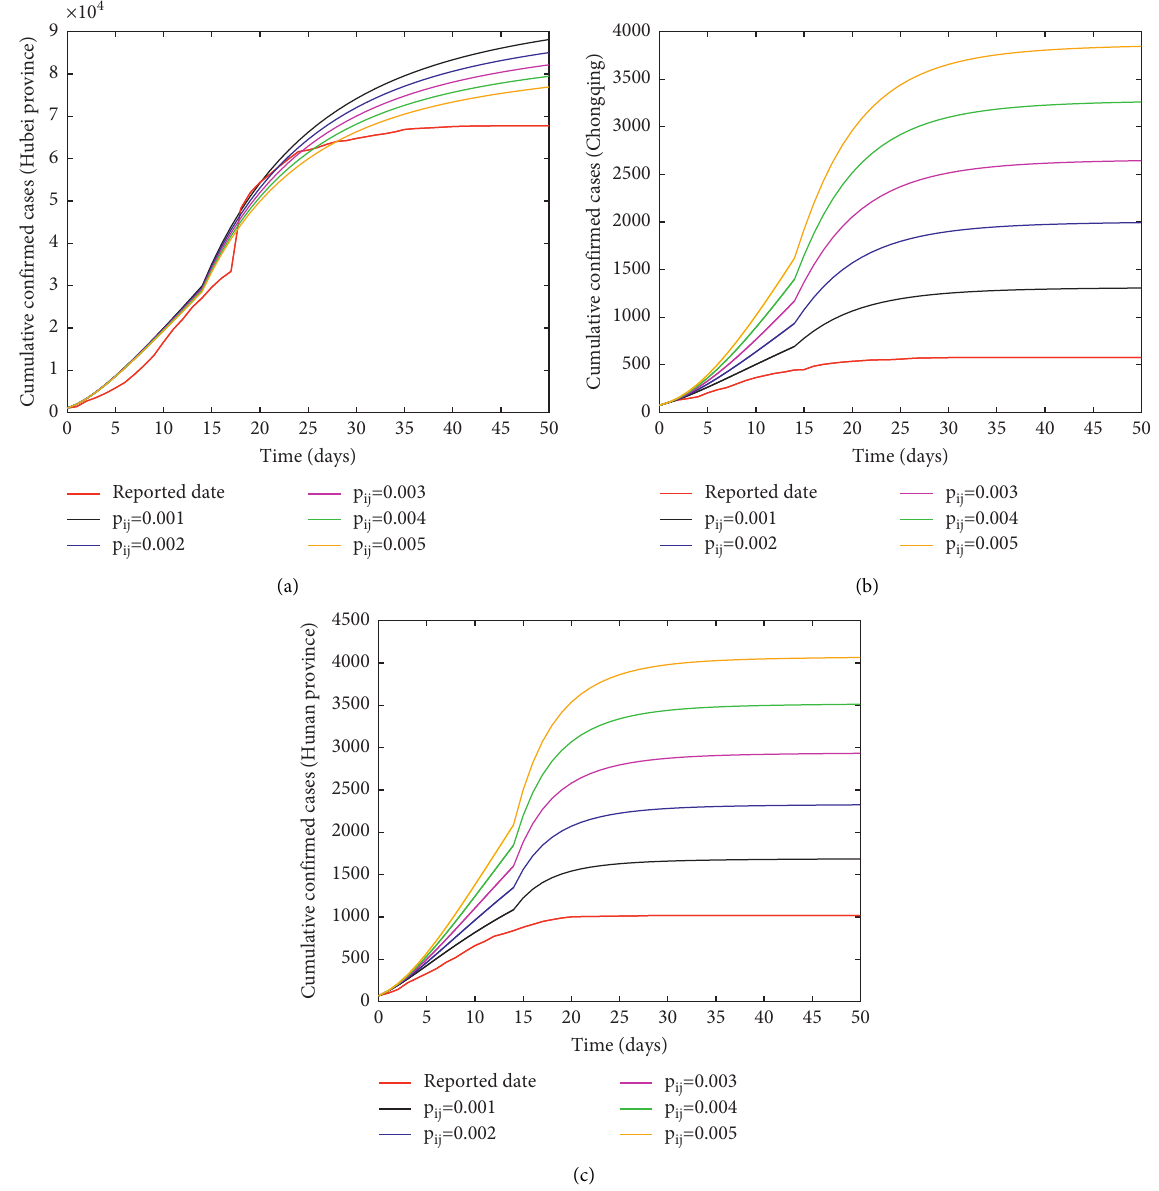
Figure 3: Effect of migration rate on COVID-19 transmission, where i , j � 1, 2, 3: (a) Hubei province; (b) Chongqing; (c) Hunan